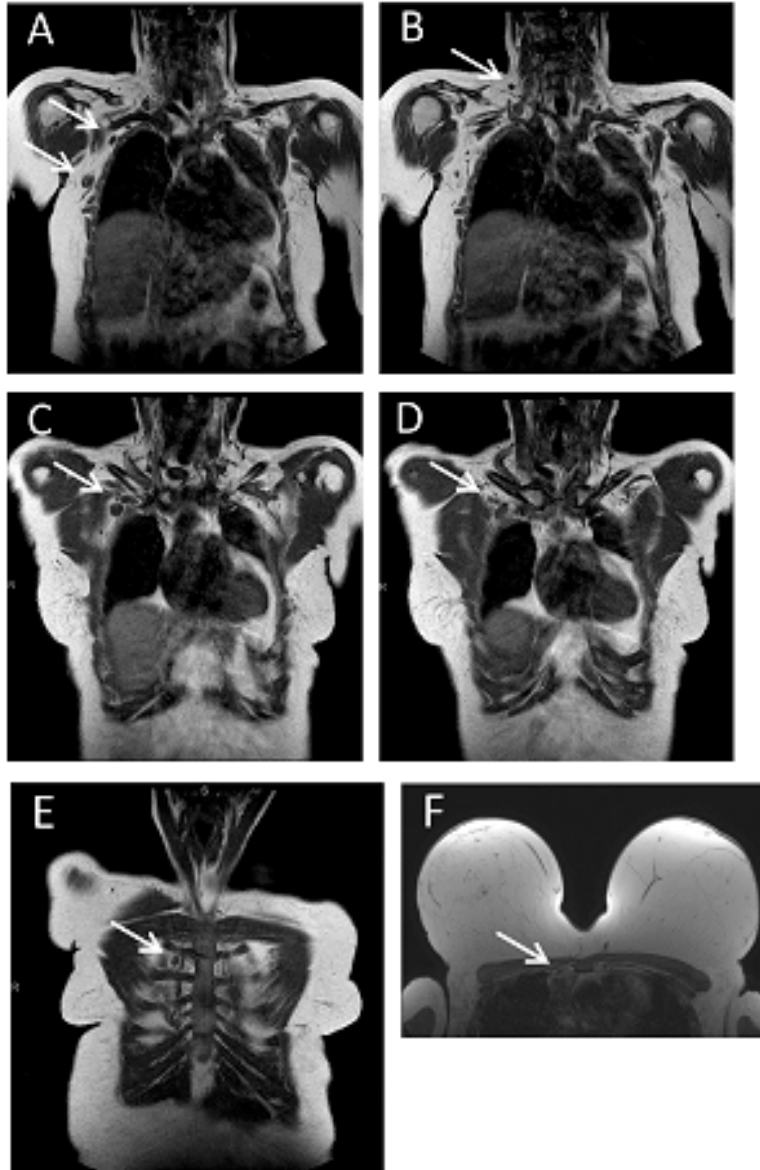
Figure 2. Pathologic nodal findings. ( A , B ): 52-year-old women with newly diagnosed Her2-negative luminal B breast cancer of the right breast. A, B, two consecutive sections of the coronal T1-weighted TSE sequence. Coronal T1-weighted TSE images depict axillary lymph node metastases level 1 and level 3 ( A ), and a supra-clavicular lymph node ( B ). ( C , D ): 32-year-old female patient with newly diagnosed triple-negative breast cancer of the right breast. Coronal T1-weighted TSE image depicts infraclavicular lymph nodes. ( E , F ): Parasternal lymph node metastasis in a 44-year old female women with newly diagnosed triple negative breast cancer of the right breast. ( E ), coronal T1-weighted TSE image obtained with the body coil, ( F ), axial pre-contrast T1-weighted image obtained with the breast coil. Note that the lymph node is far better visible on the coronal image compared to the axial image. Arrows indicate the lymph nodes.